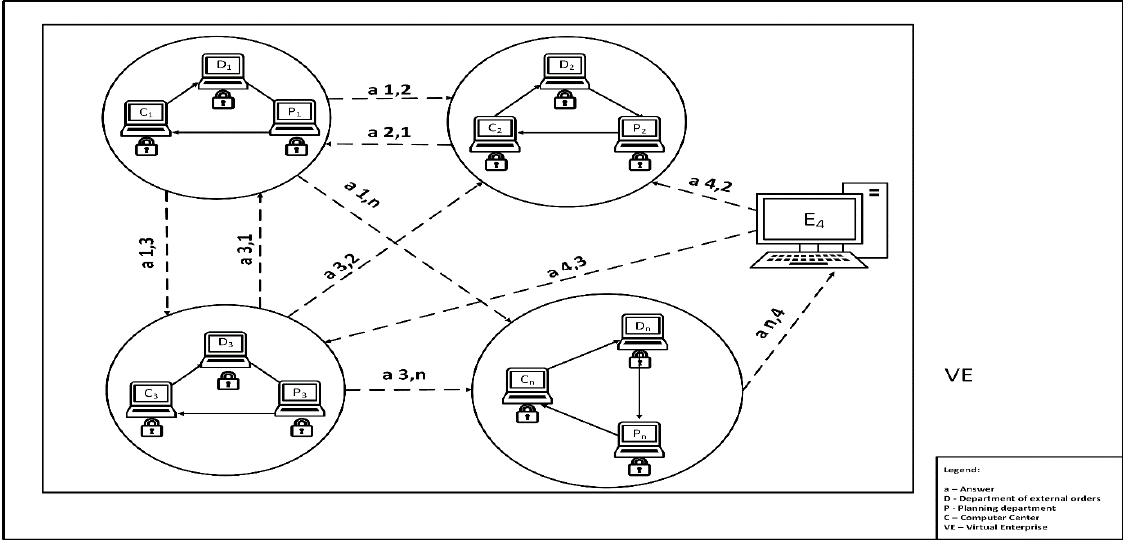
Figure 2. Responses to the tender with preliminary terms of the contract using consortium blockchain.